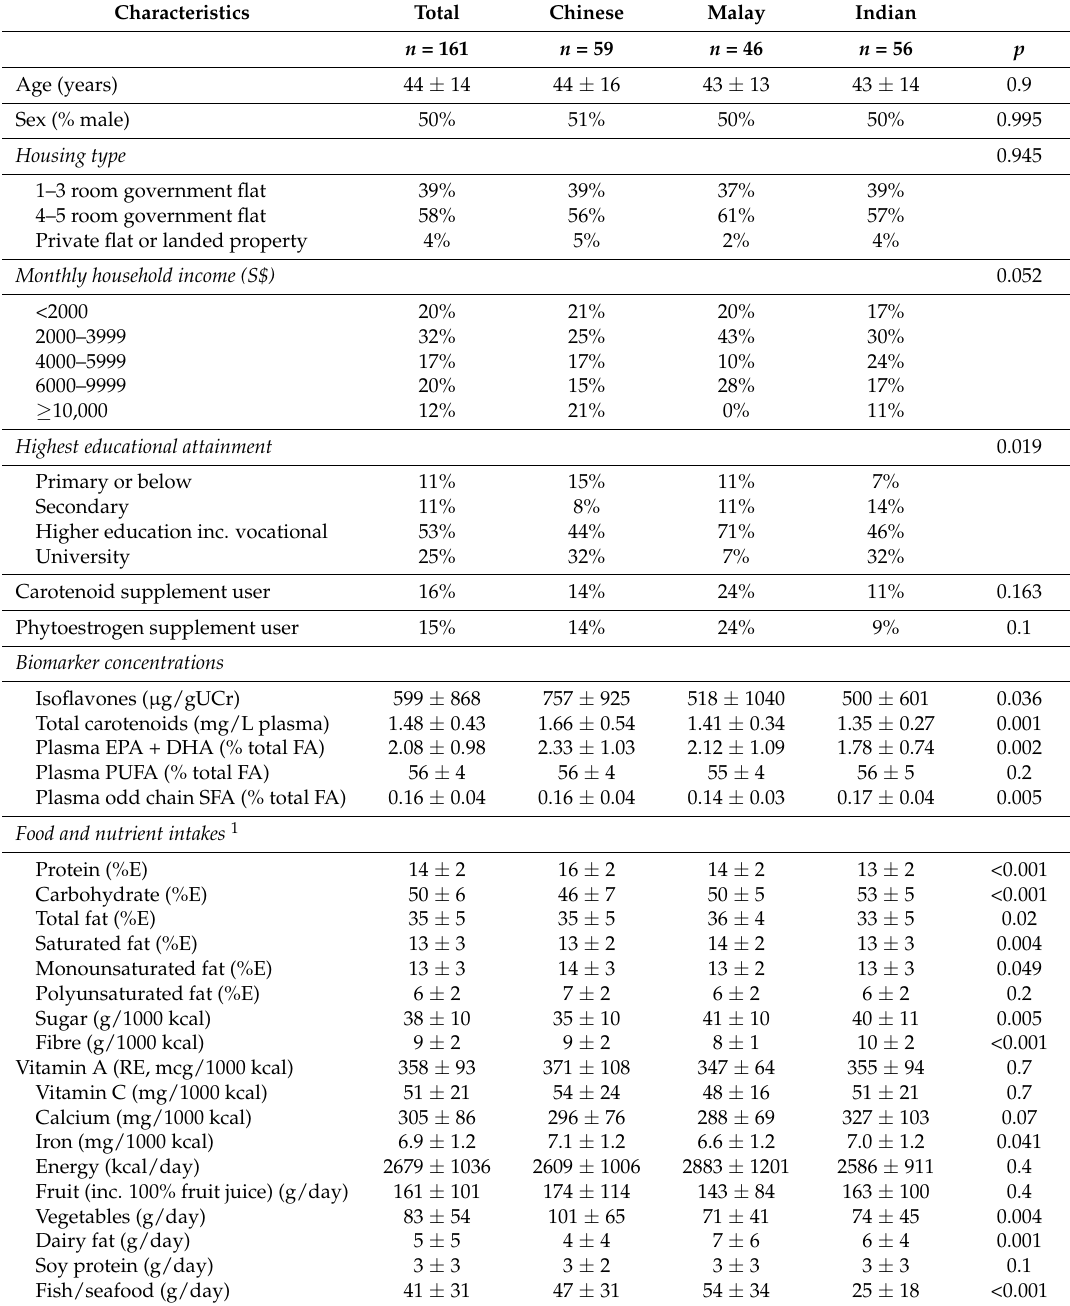
Table 1. Study participant characteristics and intakes of selected foods and